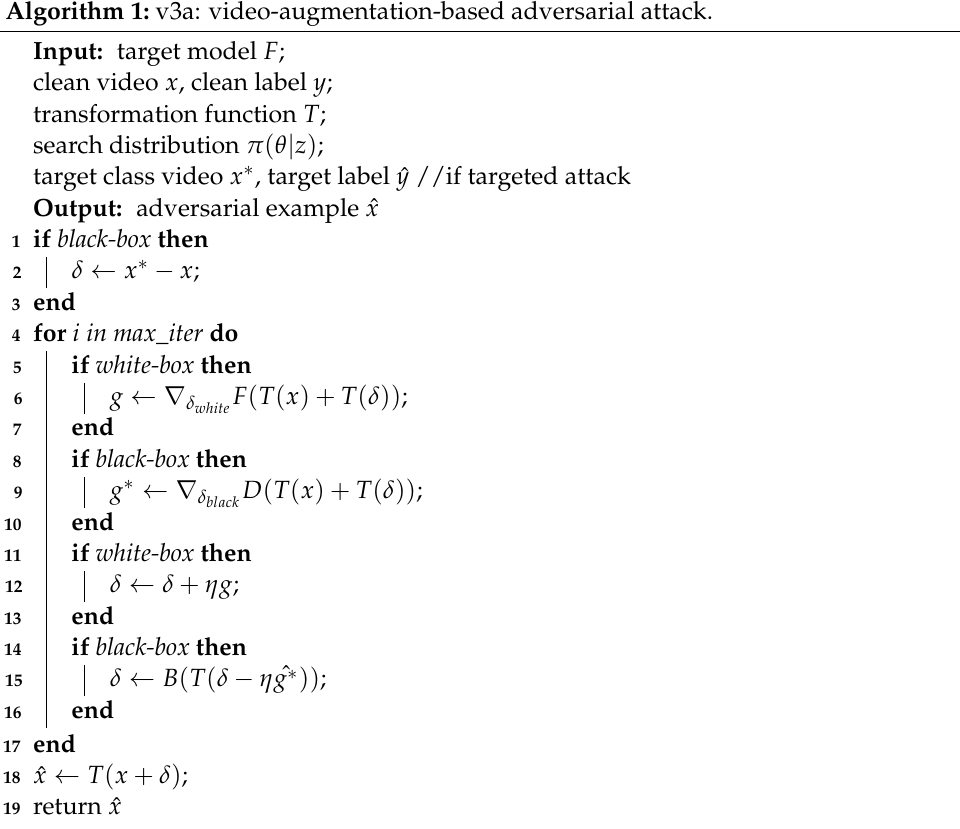
Algorithm 1 show the implementation of v3a. Algorithm 1: v3a: video-augmentation-based adversarial